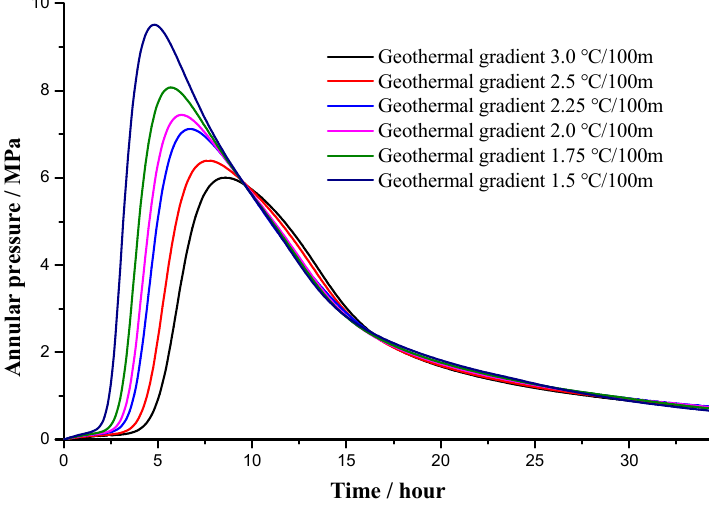
Figure 12. Annular pressure under different geothermal gradients.